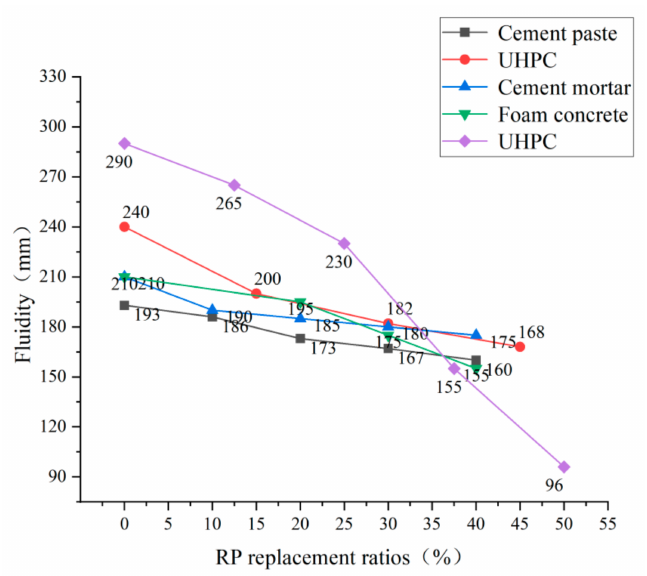
Figure 8. Fluidity of cement-based materials under different replacement rates of RP